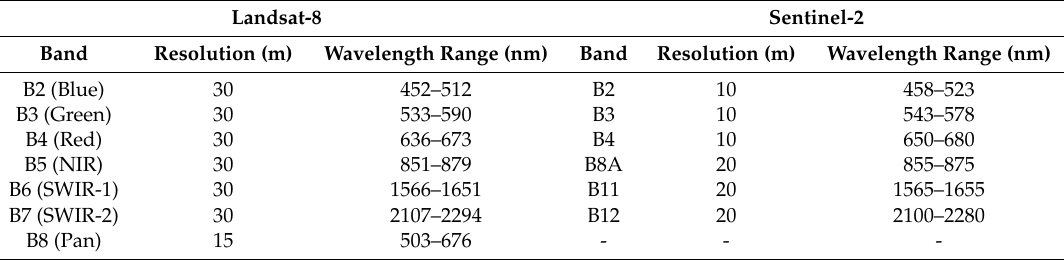
Table 1. Landsat-8 OLI and Sentinel-2 MSI equivalent spectral bands [2,23] considered in this study.